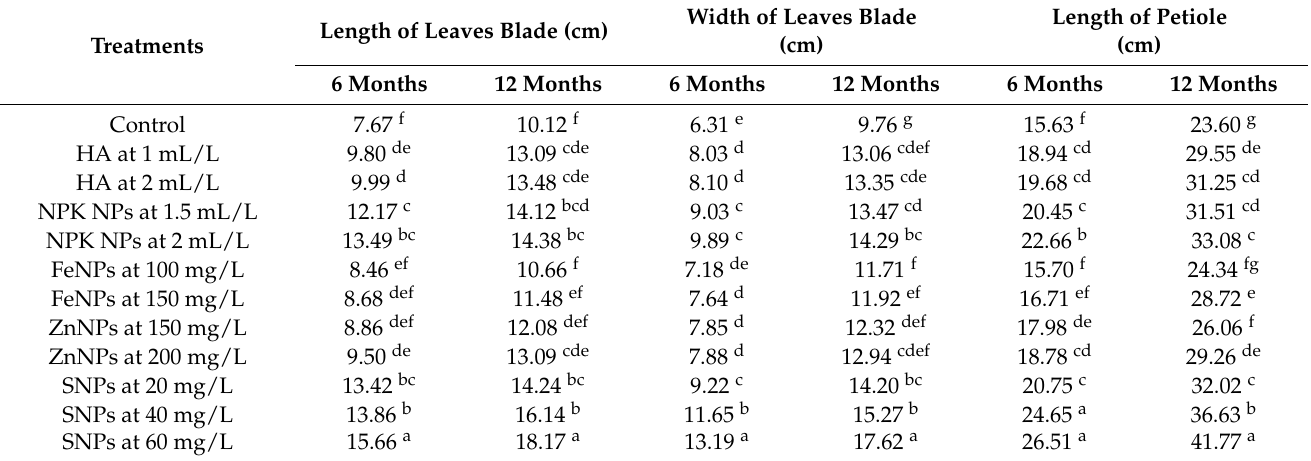
Table 2. Effect of nanoparticles and humic acid on length and width of leaves blade and length of petiole in Philodendron bipinnatifidum after 6 months and 12 months during 2019/2020 and 2020/2021